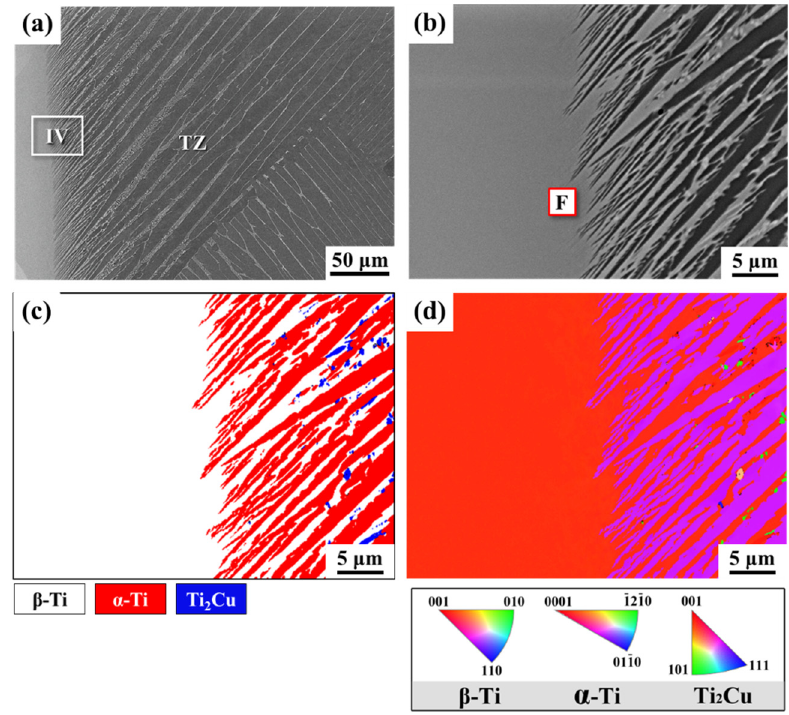
Figure 4. SEM-BEI photos and EBSD maps of Ti-1553/Ti–Cu–Ni/CP-Ti joint brazed at 1243 K for 30 min: ( a ) cross-section overview; ( b ) higher magnification of the region IV in 4a; ( c – d ) EBSD phase map and inverse pole figure (IPF) map of 4b.